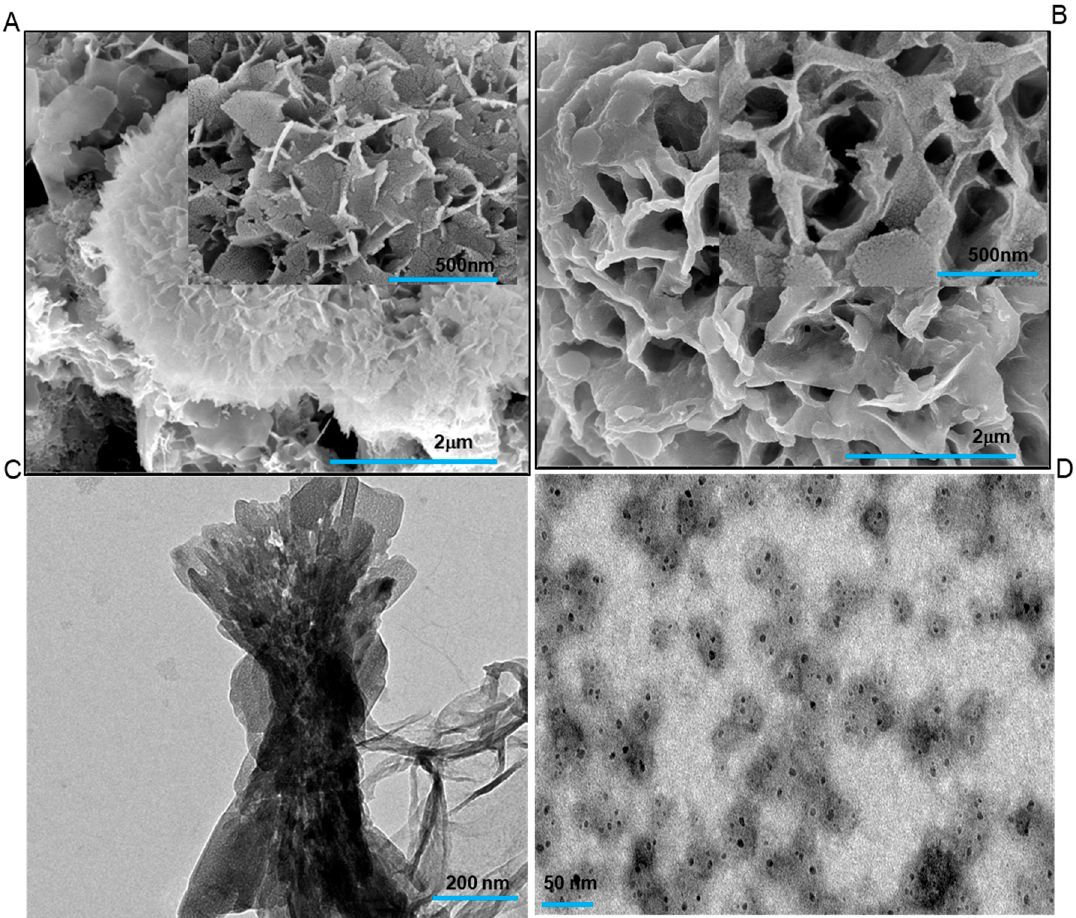
Figure 4. ( A ) Control FESEM micrograph of calcium phosphate mineralization in the absence of any protein. The inset shows the calcium phosphate flakes at 500 nm, whereas the representative TEM image of calcium phosphate control is shown in ( C ). FESEM micrograph at ( B ) shows the absence of mineralization in the presence of Bovine serum albumin (BSA) protein and calcium phosphates. ( D ) shows the TEM image in the presence of BSA and calcium phosphates.